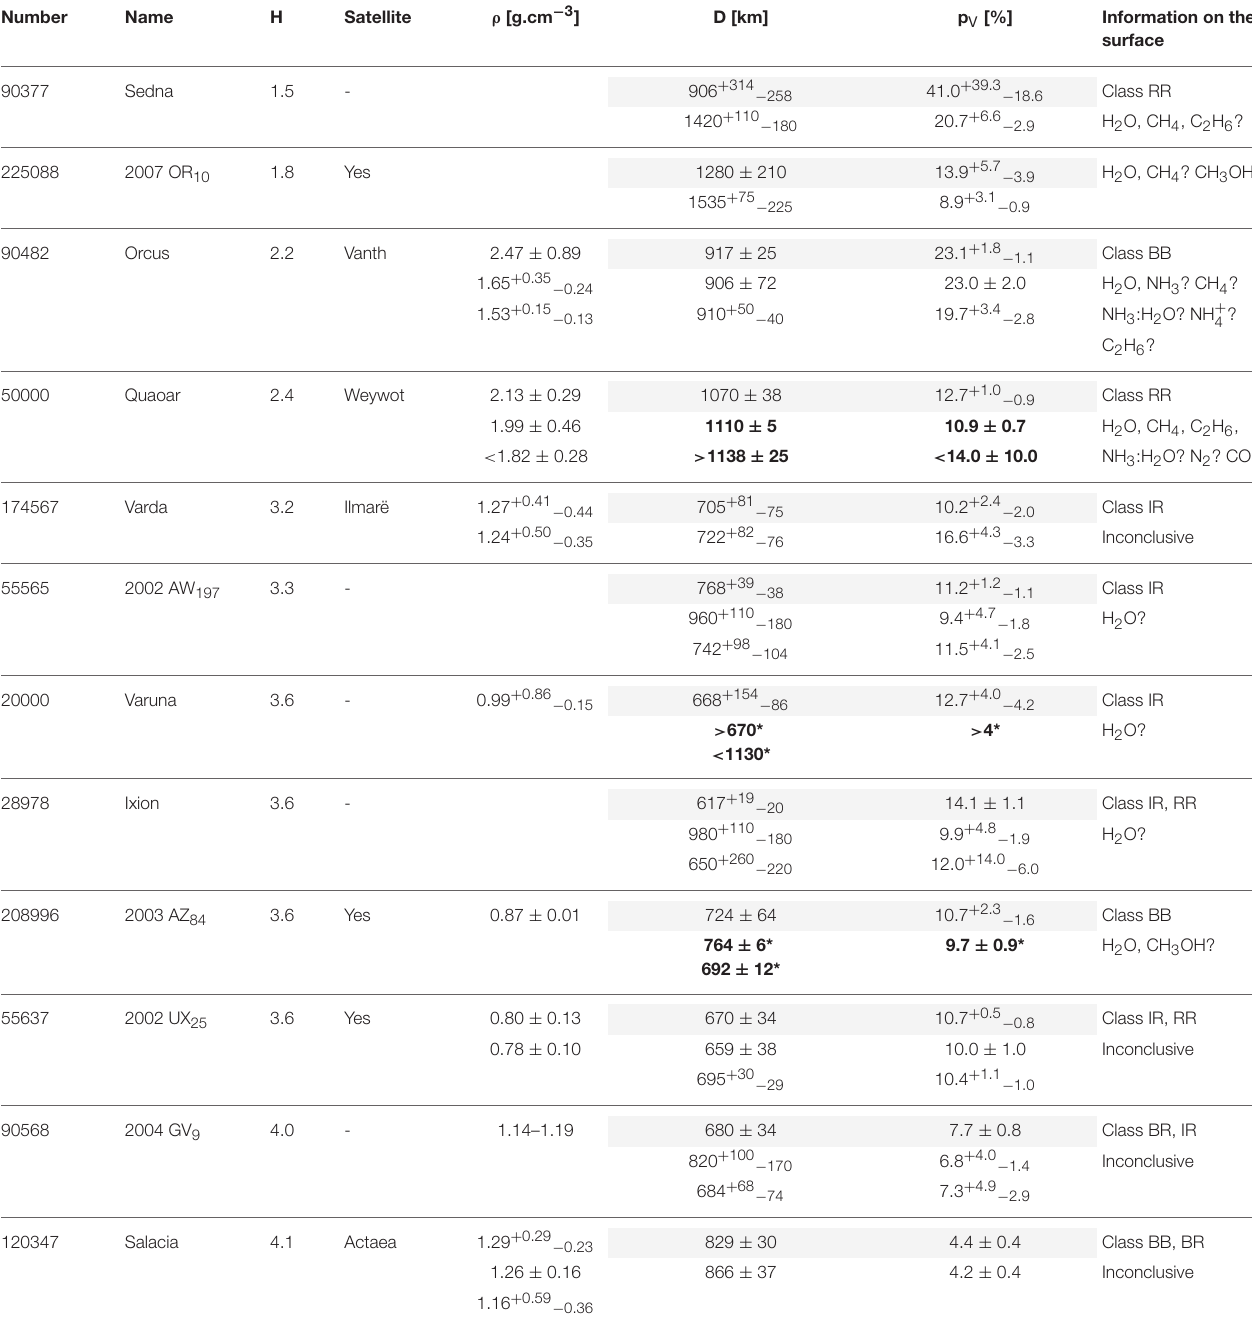
TABLE 1 | Physical properties of selected mid-sized